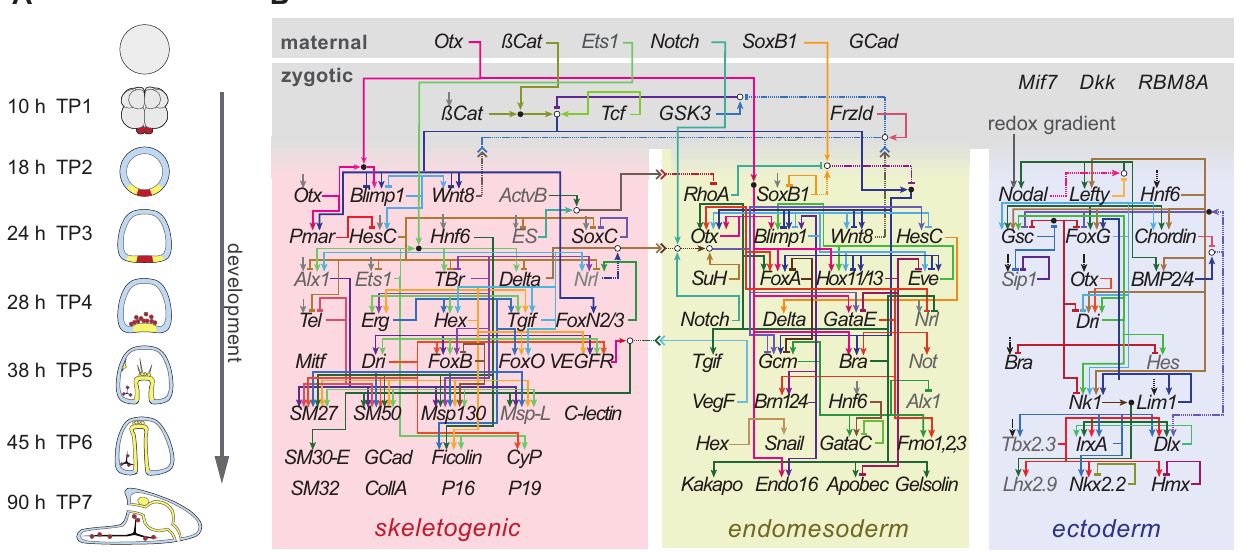
Figure 1. Developmental gene regulatory network of S.purpuratus . (A) Development progresses from the egg (top), through cleavage and gastrulation (middle), to a free living larva capable of feeding (bottom). Skeletogenic cell lineage indicated in red, skeleton in solid black. The seven post-fertilization stages and times (hours) shown correspond to time points 1–7 discussed throughout this article. (B) The gene regulatory network is initiated by maternal transcripts and proteins (top) that activate a cascade of subsequent gene regulatory interactions (see text for references). Names of genes assayed in this study are shown in black, other genes in gray. Solid lines, colored to allow visual separation, denote experimentally verified direct molecular interactions among genes: transcription factor:DNA binding (arrows=activators, bars=repressors) or ligand:receptor interactions (nested arrowheads pointing to receptor). Distinct spatial territories of cell fates specific in the embryo are indicated by colored background and name. Based on